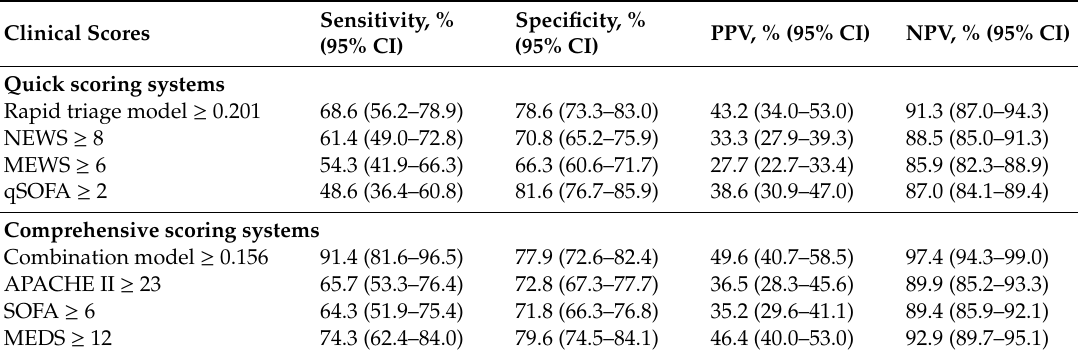
Table 4. Performance of scoring systems for the prediction of 30-day